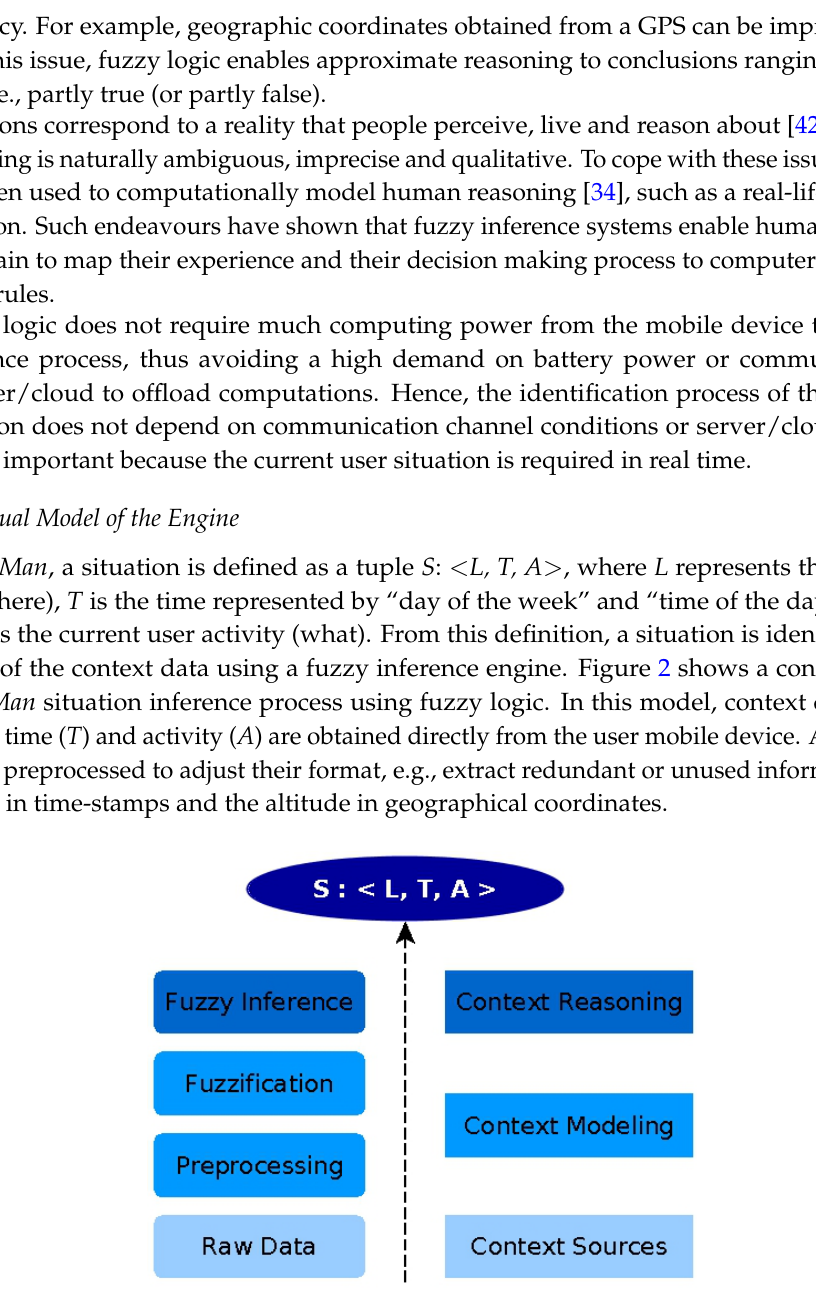
Figure 2. Conceptual model of user situation inference using fuzzy